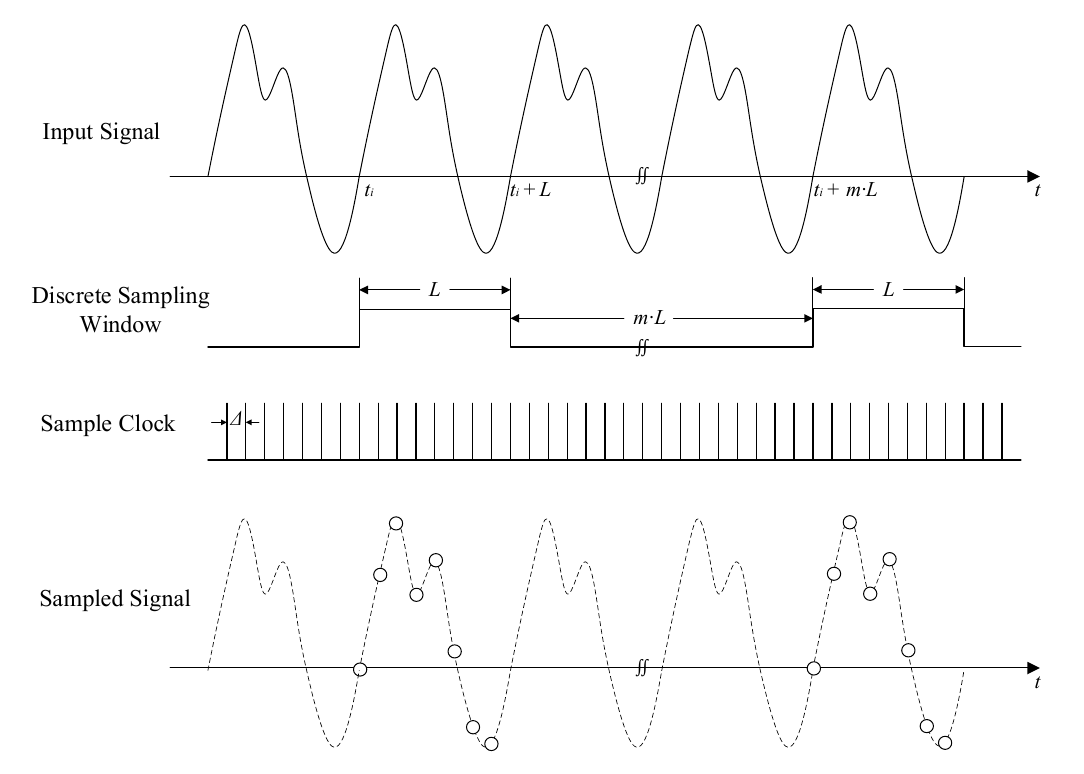
Figure 3. Signal digitization with discrete sampling window method.